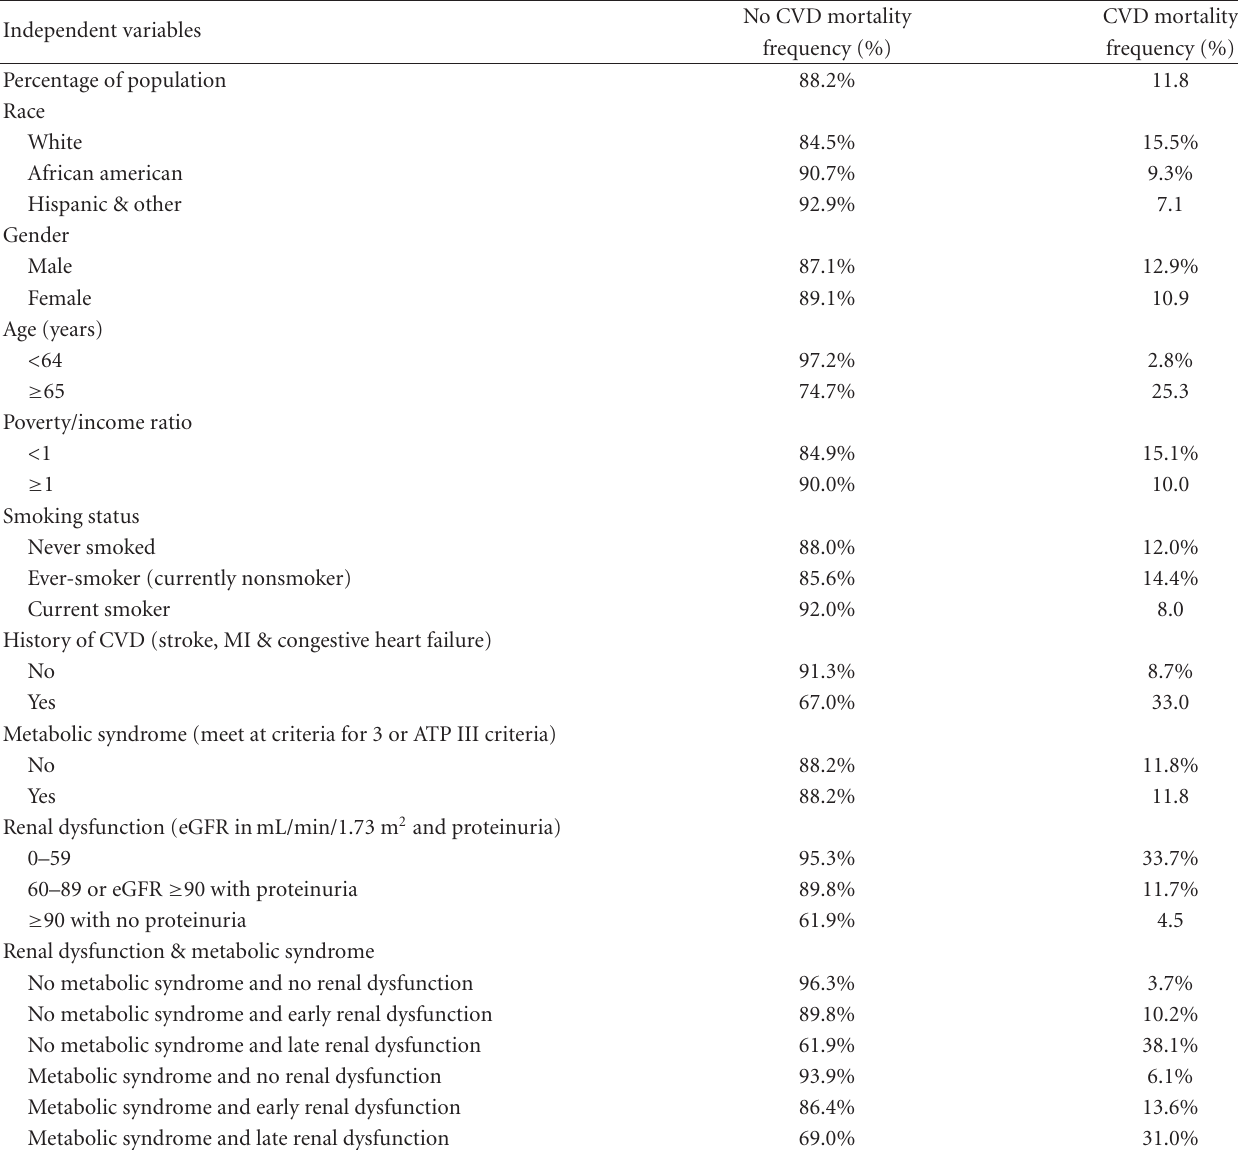
Table 2: Distribution of Independent Variables and Cardiovascular Disease Mortality ( n =